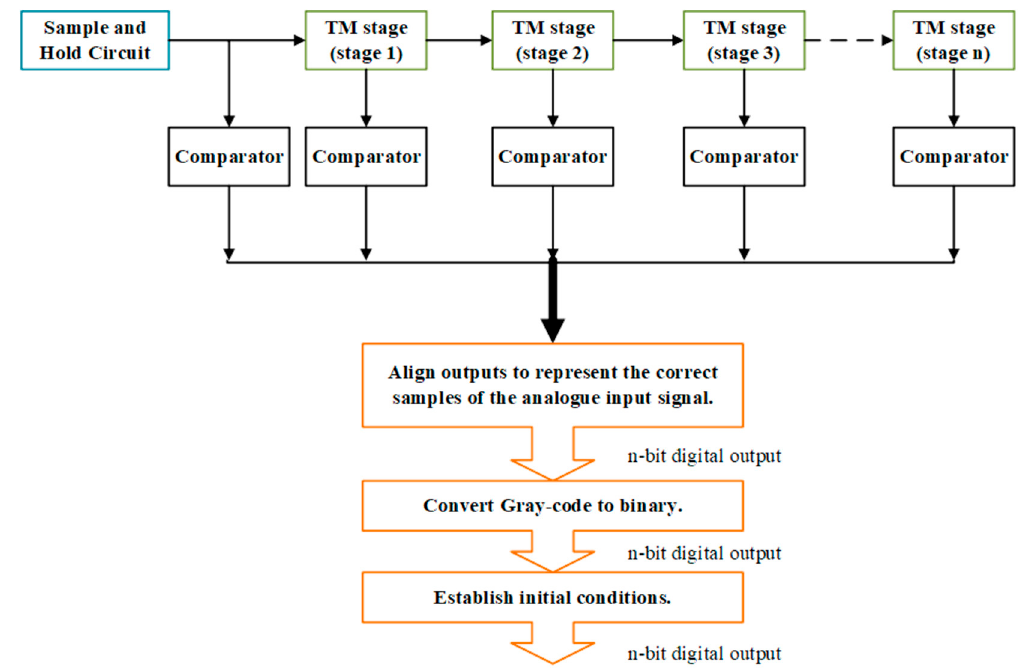
Figure 4. Proposed TM-based ADC and compensation system design, based on [8]. Adapted from [11].